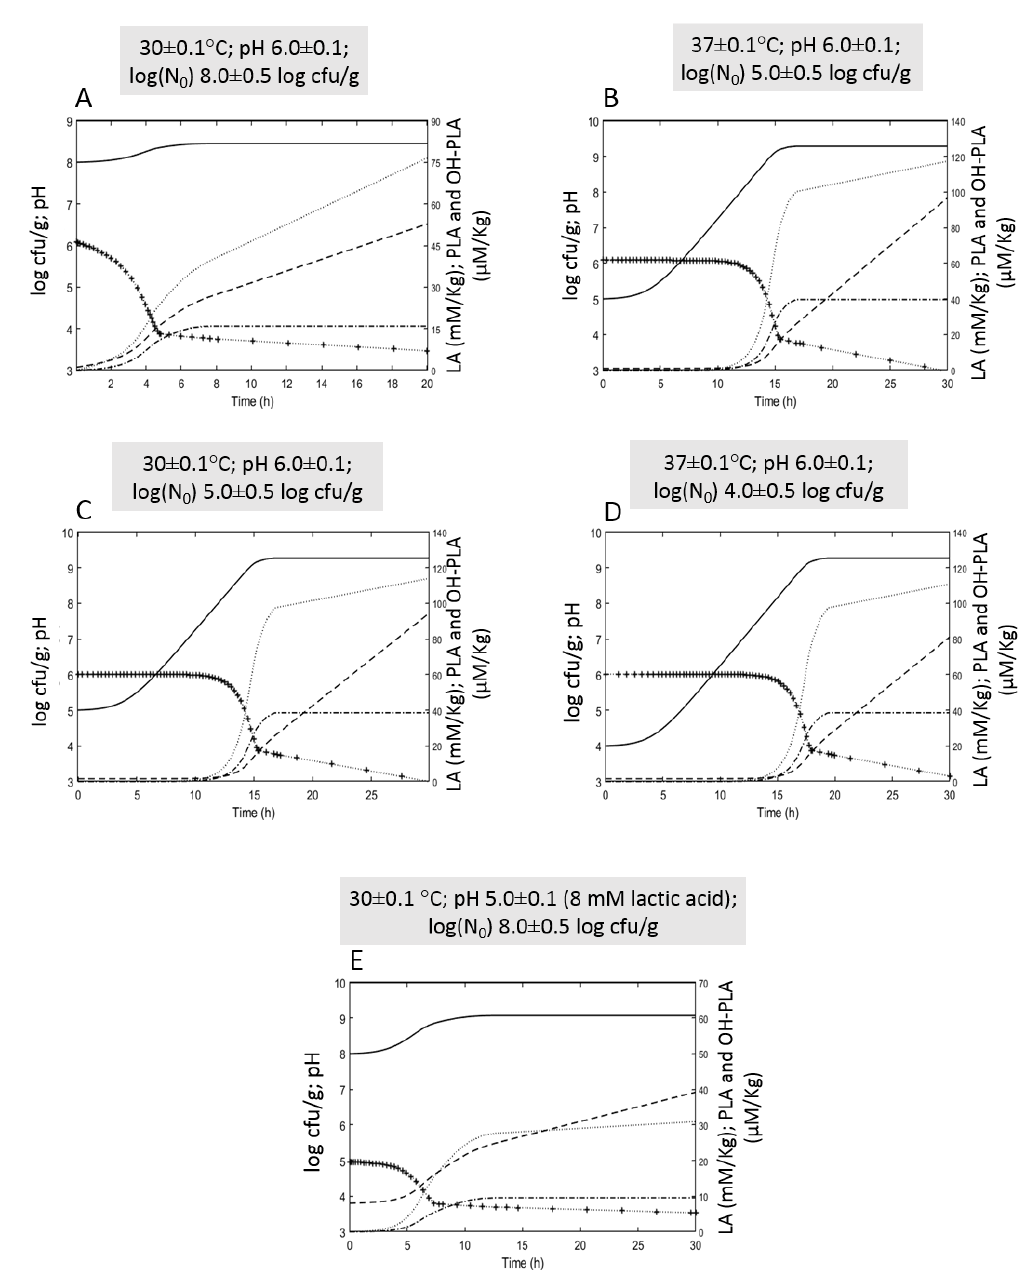
Figure 7. In silico growth simulations, pH reduction, and organic acid production in liquid sourdough at different starting fermentation conditions. Scenario A : 30 °C, pH 6.0, log(N 0 ) 8.0 cfu/g; Scenario B : 37 °C, pH 6.0, log(N 0 ) 5.0 cfu/g; Scenario C : 30 °C, pH 6, log(N 0 ) 5.0 cfu/g; Scenario D : 37 °C, pH 6.0, log(N 0 ) 4.0 cfu/g; Scenario E : 30 °C, pH 5.0 (8 mM lactic acid), log(N 0 ) 8.0 cfu/g. Log cfu/g: straight line; pH: plus-dotted line; lactic acid (LA): dashed line; phenyllactic acid (PLA): dotted line; hydroxy-phenyllactic (OH-PLA): dash-dotted line.